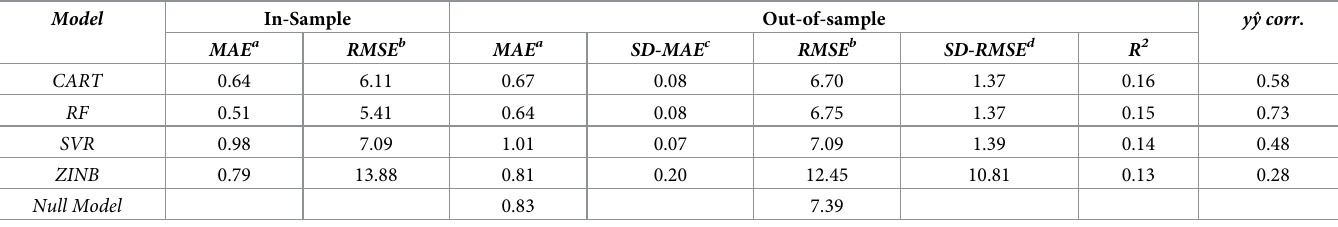
Table 2. Summary of model performance for FPR model.